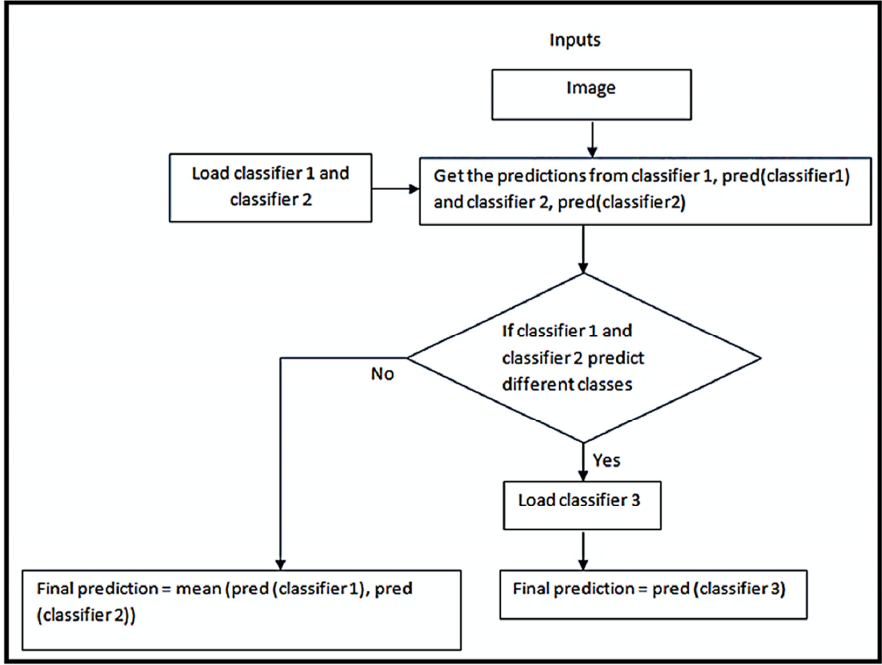
Figure 3. Strategy to construct a novel ensemble